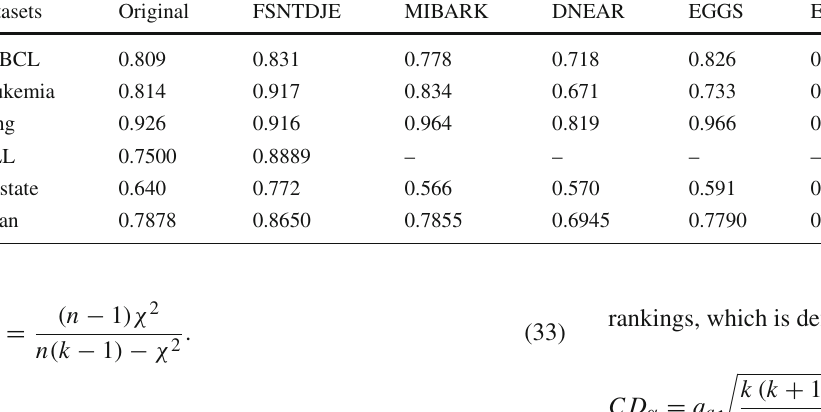
Table 10 Classification accuracy of the seven methods under the C4.5 classifier